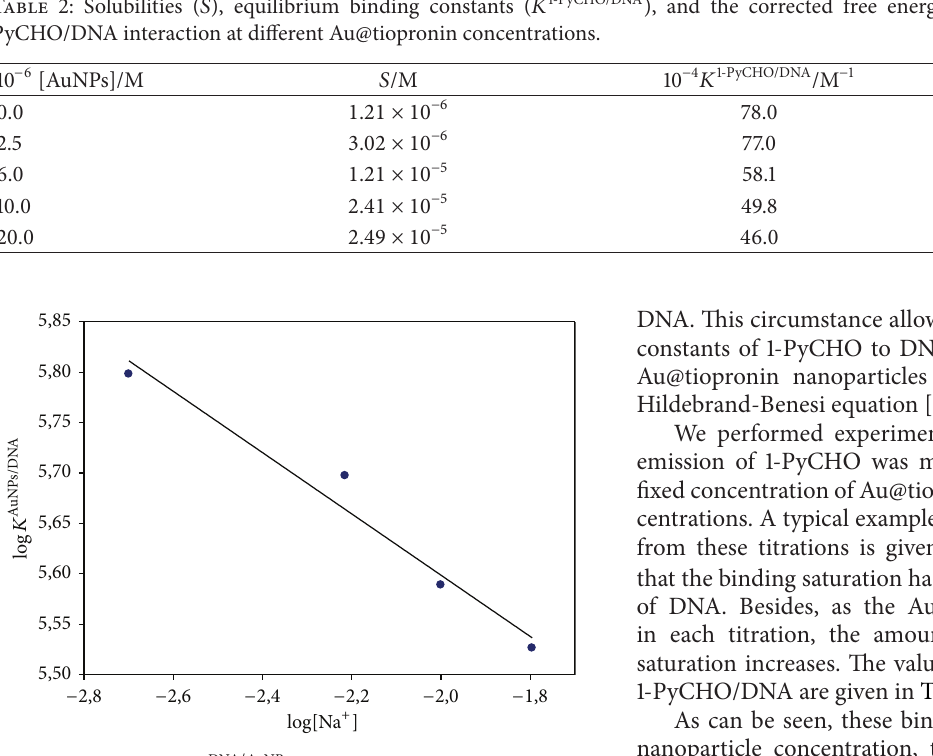
Figure 5: Plot of log 𝐾 DNA / AuNPs versus log[Na + ] (see (5)) for the DNA-AuNPs